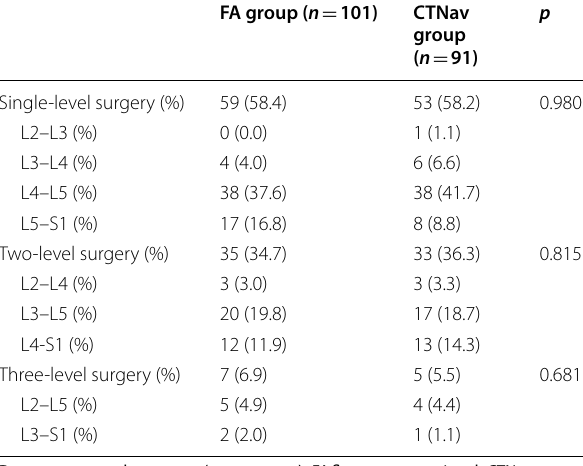
Table 2 Comparison of the operated levels between FA ( n 101) and CTNav ( n =